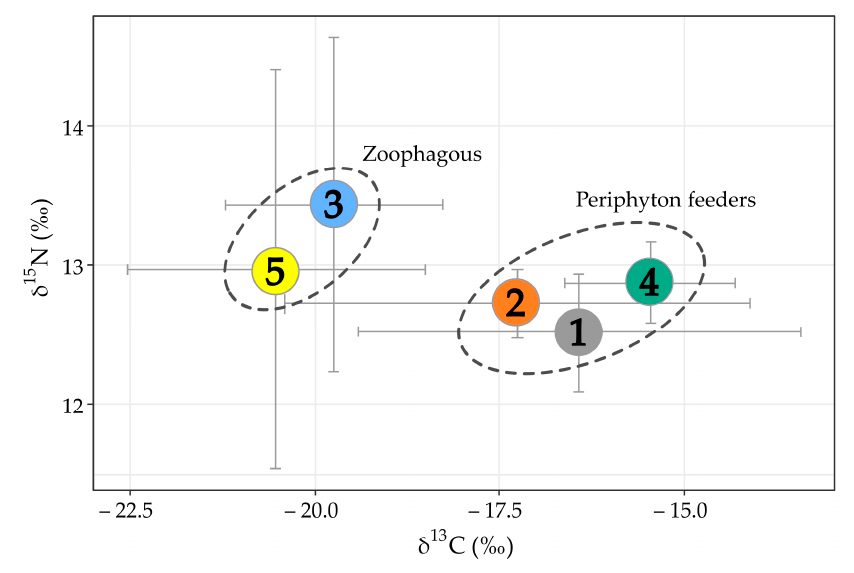
Figure 5. Biplots of stable isotope composition (means of δ 15 N and δ 13 C values ± SD) of the sympatric ecomorphs of the genus Garra (length of fish individuals: 50–90 mm, n = 44). The ellipses delineate zoophagous and periphython-feeding ecomorphs.